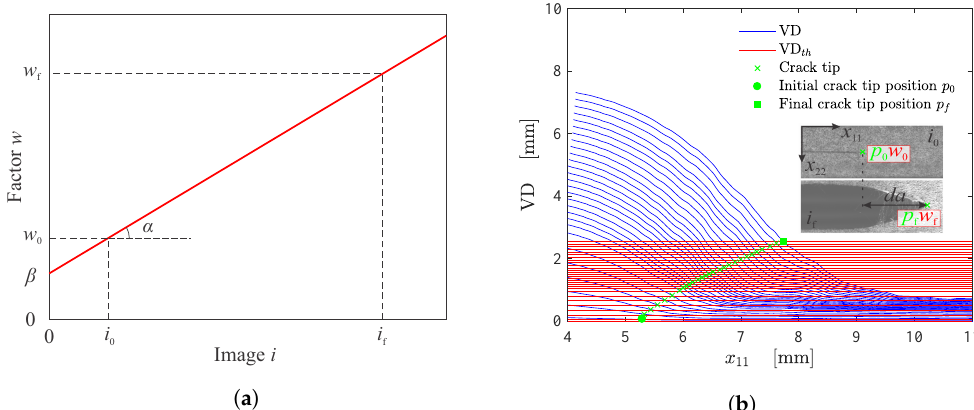
Figure 4. ( a ) Linear threshold correction factor and ( b ) estimation of crack tip position ( p ) from VDG approach. Blue curves depict the VD curve for each instant n and the red lines indicate the adjusted threshold line-cut. The intersection between VD th ( i n ) and VD ( k , i n ) corresponds to the crack tip position at instant n .